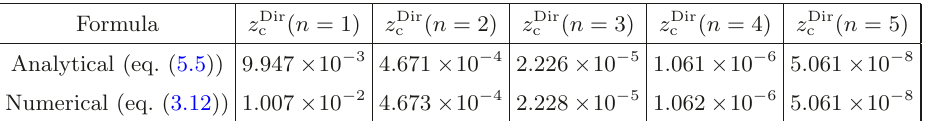
Table 3 . Spinning exotic compact objects with reflective Dirichlet boundary conditions. We